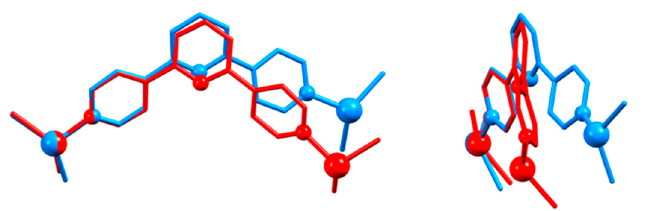
Figure 13. Two views of overlays of {(ZnCl 2 ) 2 (4,2’:6’,4” ‐ tpy)} units excised from the coordination